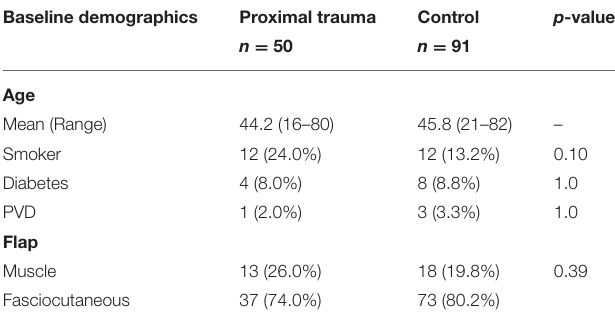
TABLE 1 | Baseline demographics for proximal trauma group and control group.